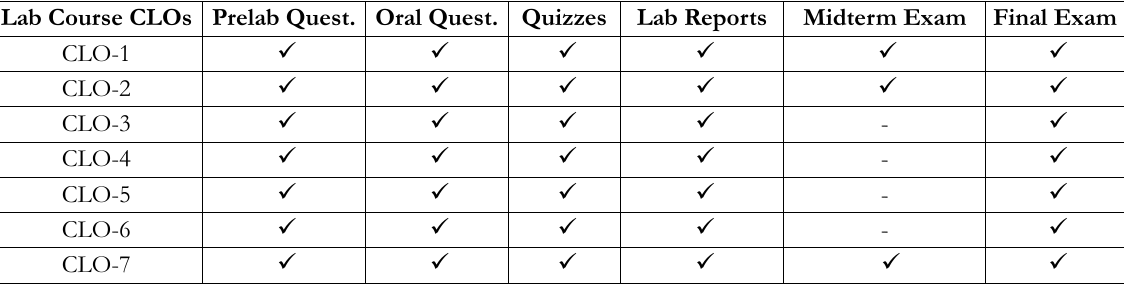
Table 5. The assessment tasks of the lab course mapped to the course learning outcomes